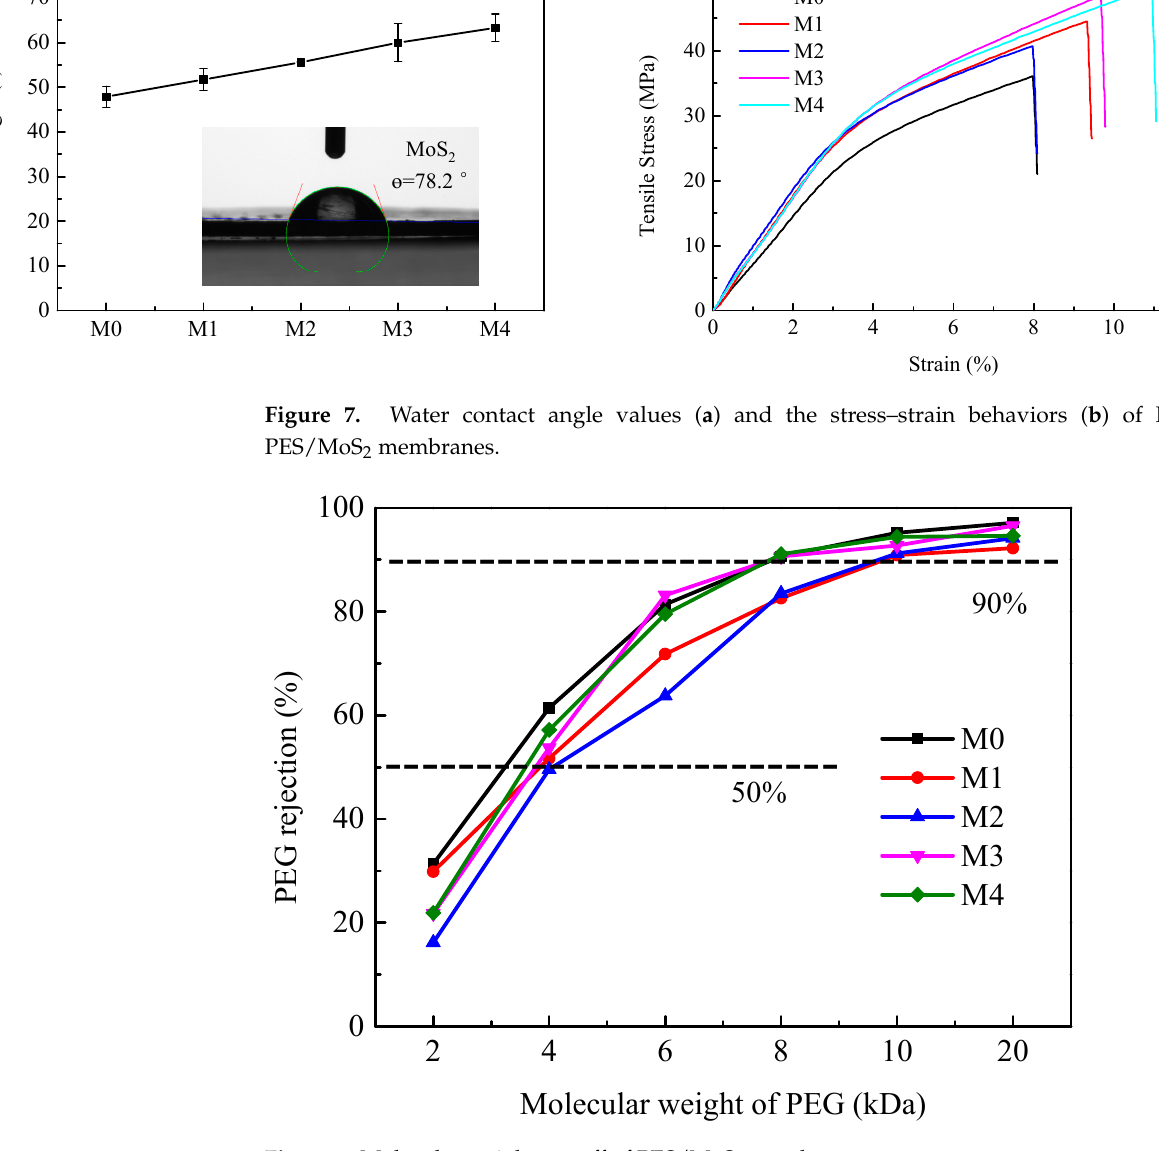
Figure 8. Molecular weight cut-off of PES/MoS 2 membranes. Table 2 also shows the pure water flux of the prepared TUF membranes. The result indicates that the pure water flux of membranes initially improved with the increased content of MoS 2 when the concentration was 0 to 0.50 wt%. The pure water flux of the M0 membrane without MoS 2 was found to be 72.37 Lm − 2 h − 1 , and it increased to 91.86 Lm − 2 h − 1 for the M1 membrane. The water flux permeability of UF membranes